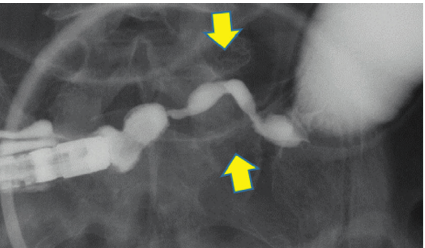
Figure 2: Contrast medium enterography. Arrow indicates the lesion site which was 4cm in